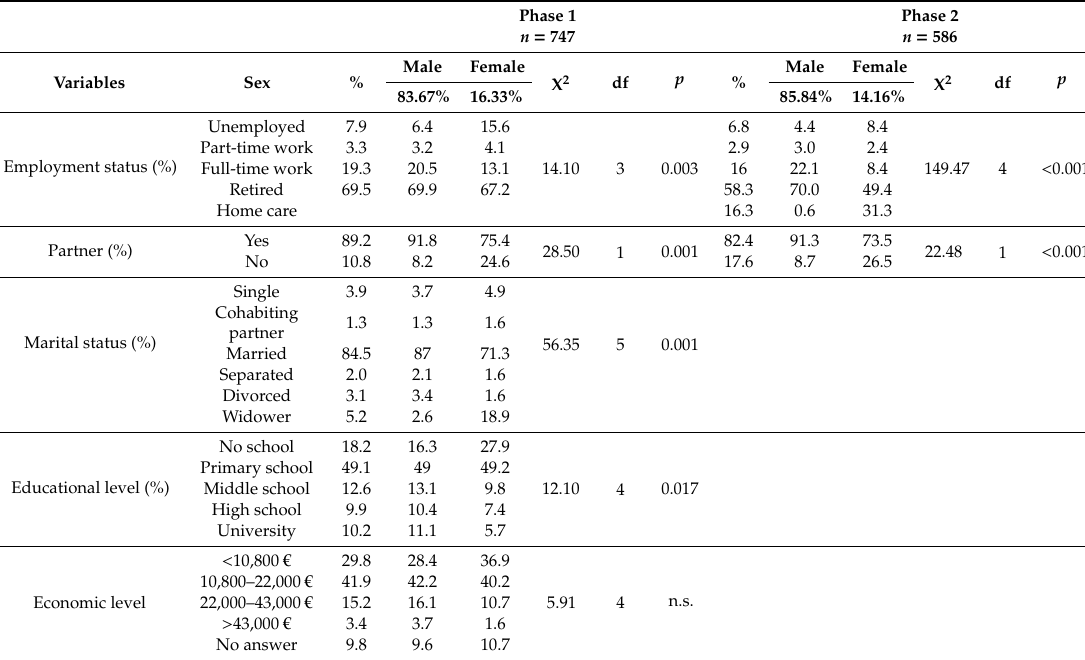
Table 1. Demographic characteristics of study participants by